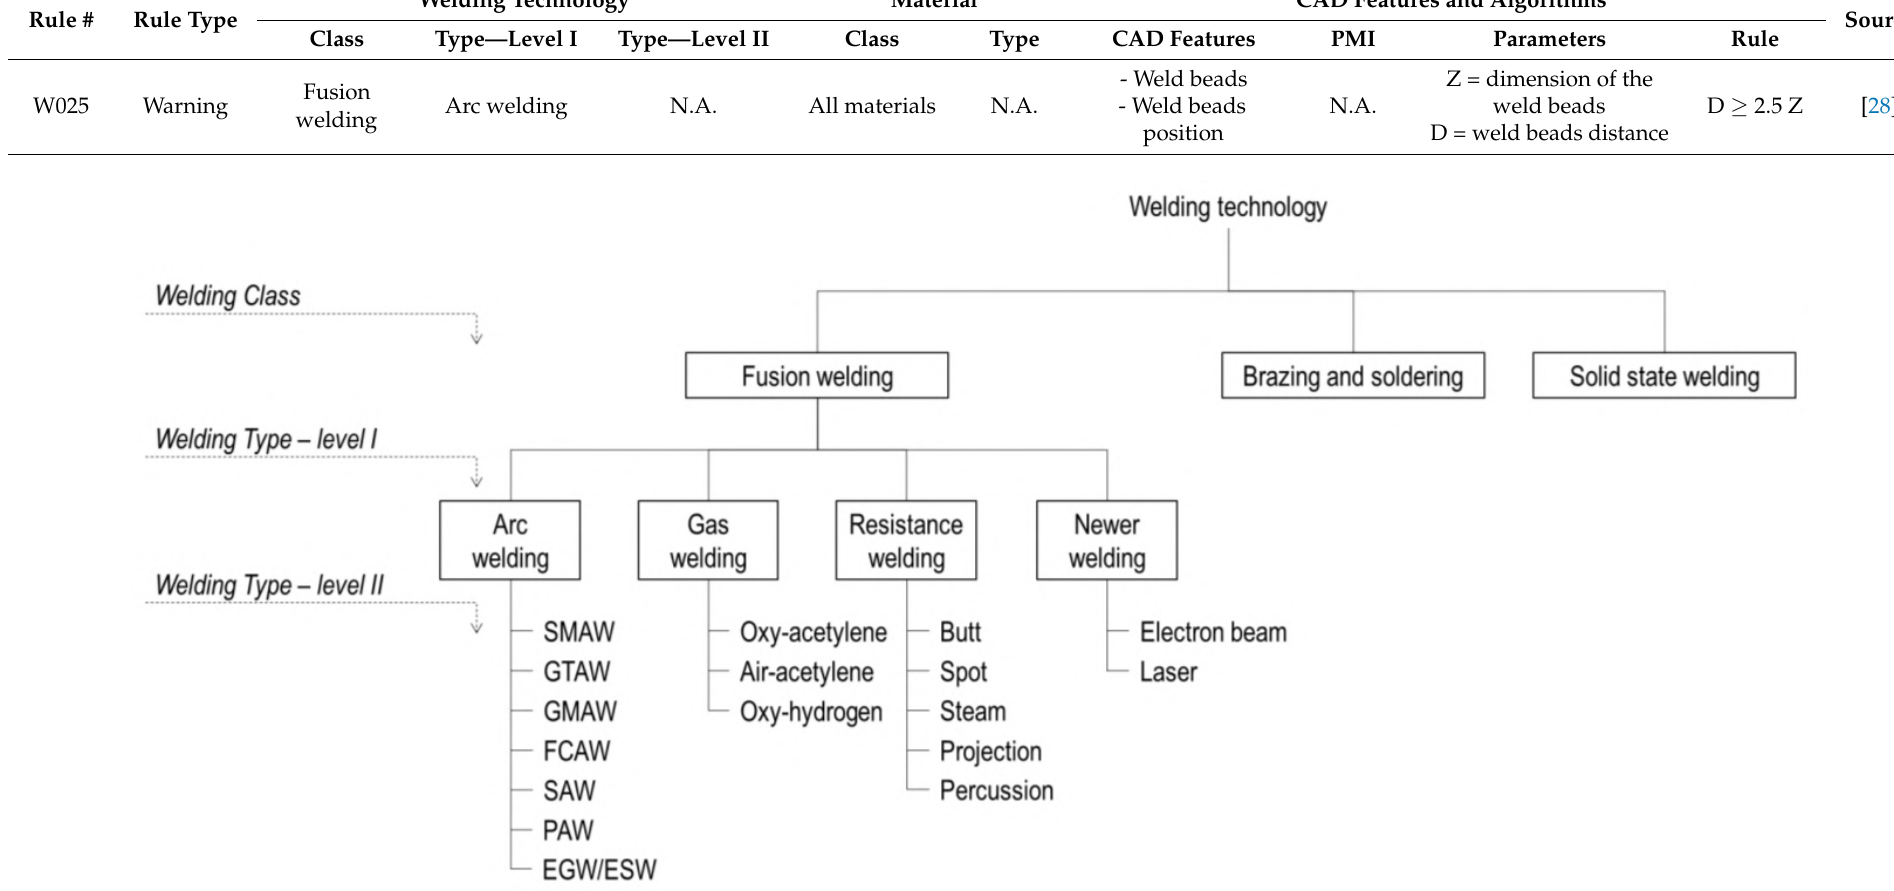
Table 1. The ontology used for the formalization of design for welding (DFW) rules (including an example).